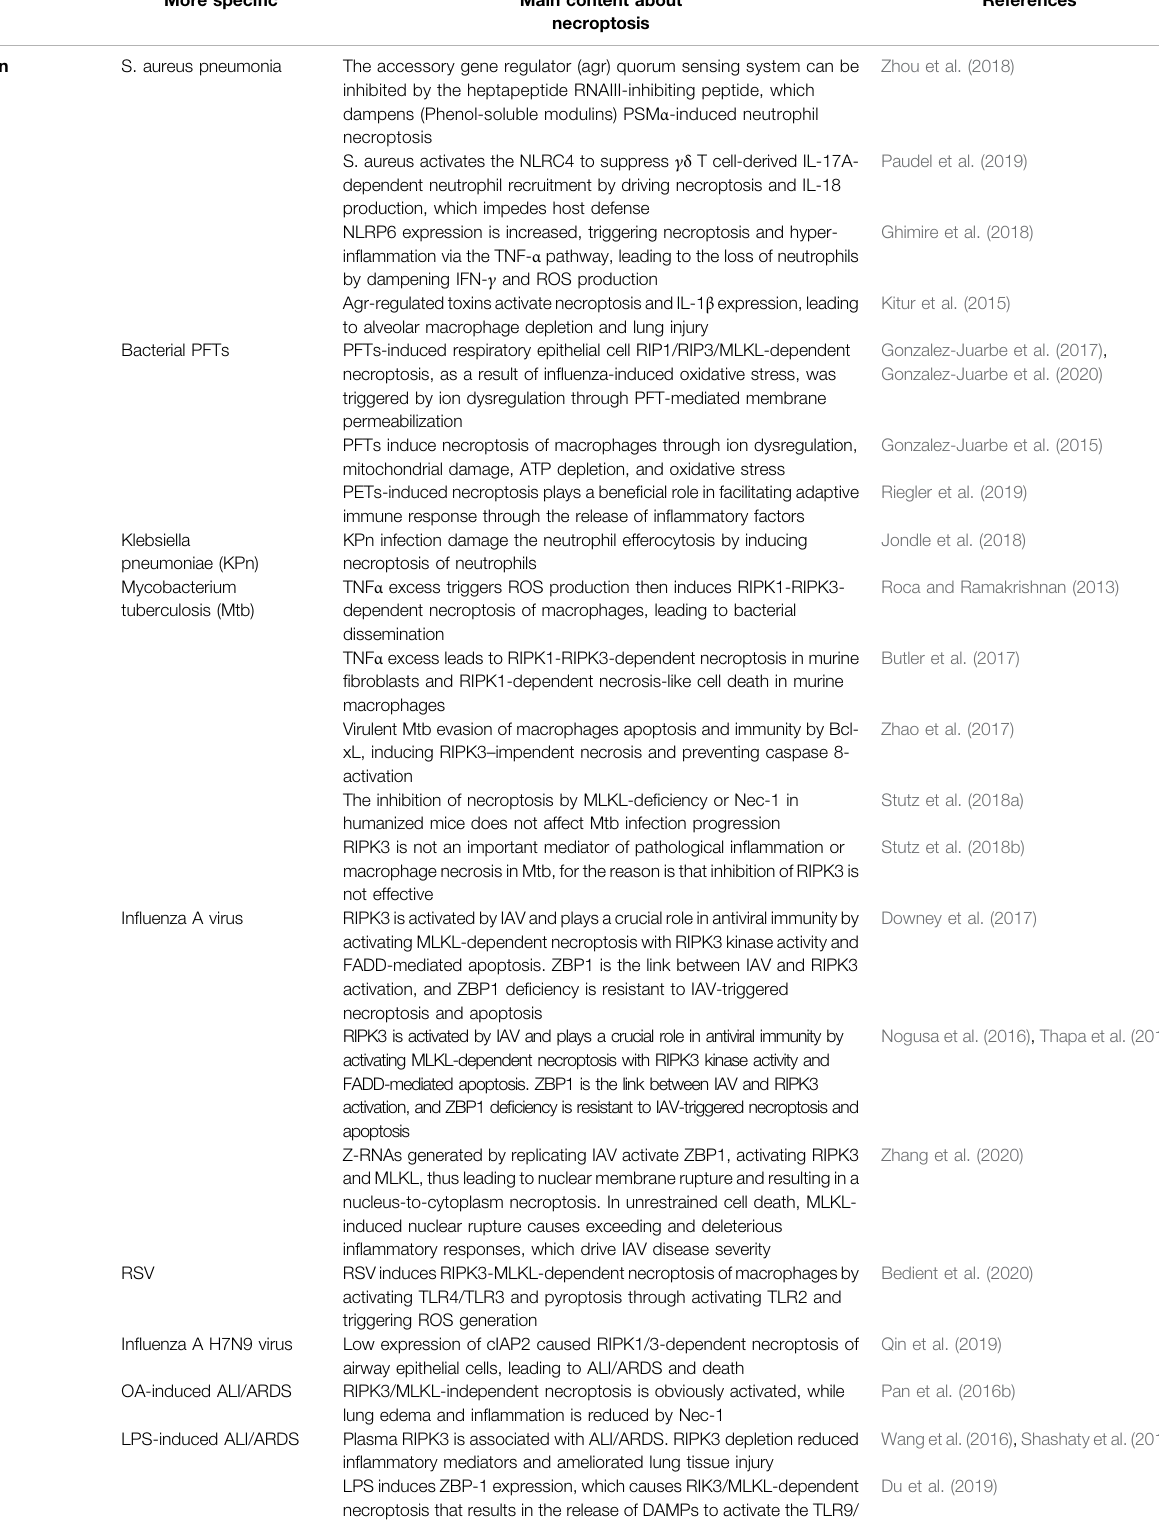
TABLE 1 | The role of necroptosis in pulmonary diseases.